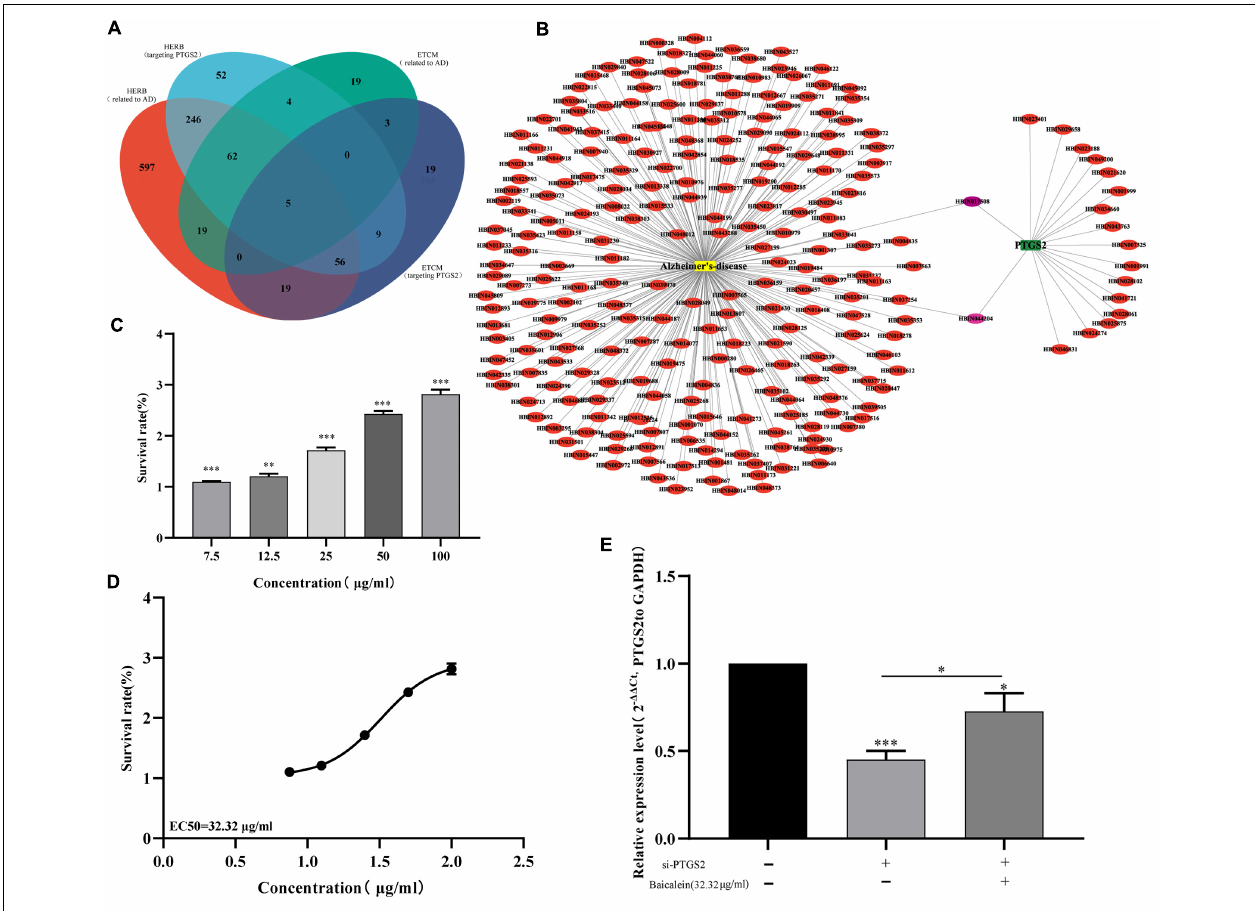
FIGURE 9 | (A) Venn diagram shows the overlap between AD related Chinese herbs and PTGS related Chinese herbs. (B) Network of AD related components in HUANGQIN and PTGS2 targeted components in HUANGQIN. (C) The effects of different concentrations baicalein on the vitality of AD model cells (A β 25 − 35 -treated SH-SY5Y cells) measured using the CCK-8 assay. (D) EC 50 fitting curve of baicalein in AD model cells (A β 25 − 35 -treated SH-SY5Y cells). (E) The effect of baicalein on the expression of PTGS2 by qPCR in AD model cells (A β 25 − 35 -treated SH-SY5Y cells). AD, Alzheimer’s disease. The expression level of GAPDH was used as an internal reference for PTGS2. The data are shown as the mean ± standard deviation. The horizontal line indicates the comparison between groups at both ends, and the non-horizontal line indicates the comparison with the control group. ∗∗∗ p < 0.001; ∗ p <